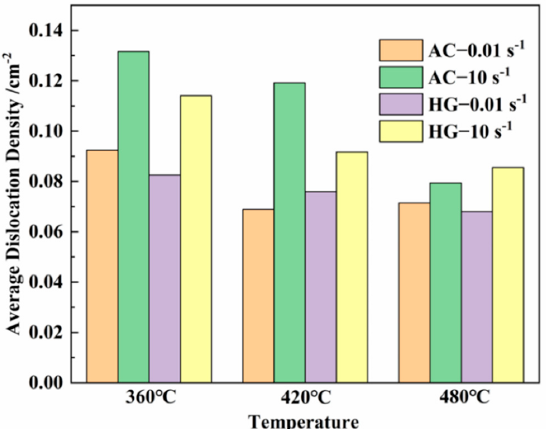
Figure 13. KAM values of AC and HG AA2195 alloy under different deformation conditions.